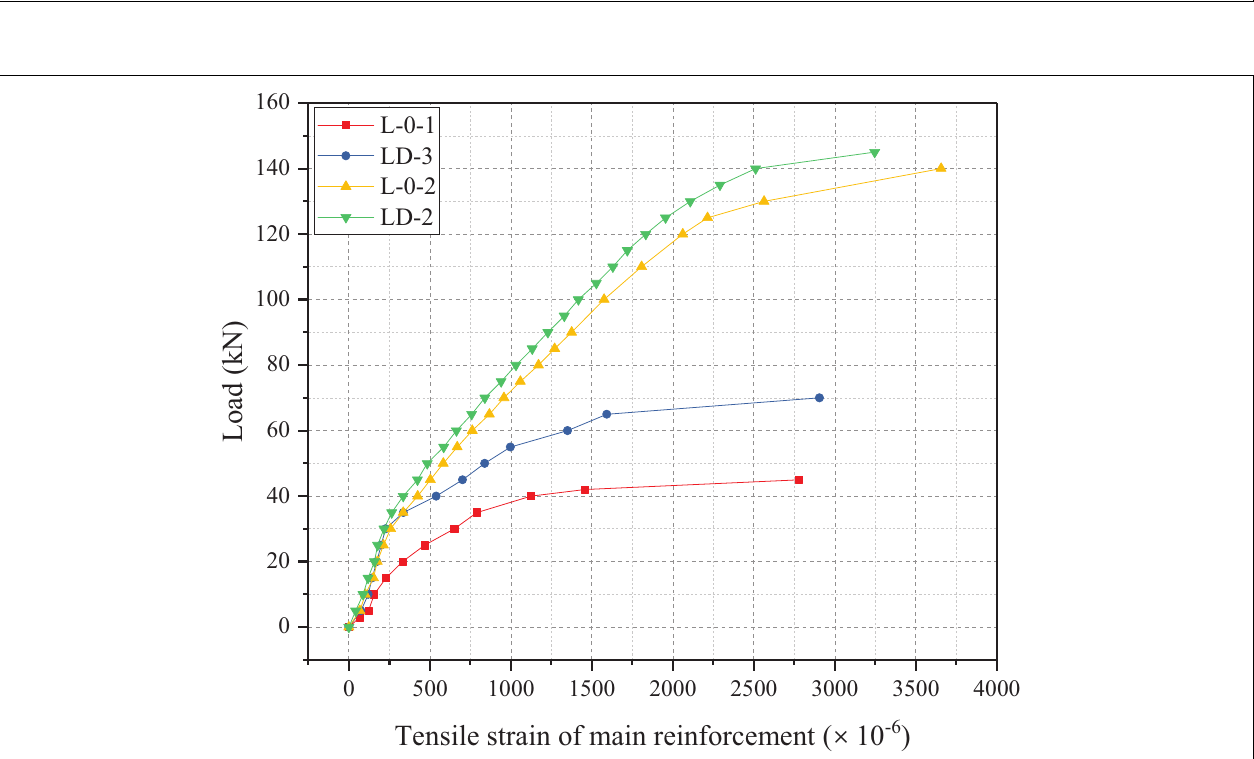
FIGURE 6 | Relationships between load and tensile strain of main